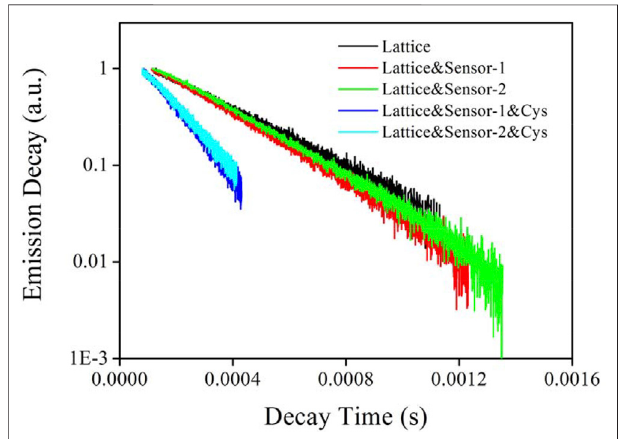
FIGURE 5 | Emission decay lifetimes of our excitation lattice (539 nm) upon the presence chemosensors and Cys (in PBS, pH = 7.0, 5 mg in 10 ml for lattice, 10 μ M for chemosensors, 10 μ M for Cys, λ ex = 980